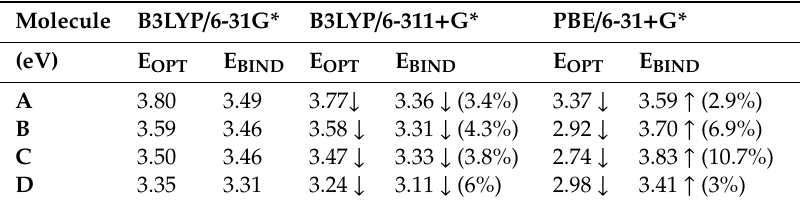
Table 5. Optical onset and exciton binding (E BIND ) energy values are reported here. The symbol ( ↓ ) is denotes a decrease and ( ↑ ) denotes an increase in the values with respect to B3LYP / 6-31G* level of